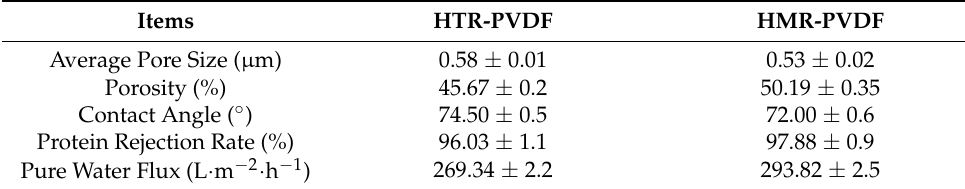
Table 2. Properties of the membranes used in this work. Items